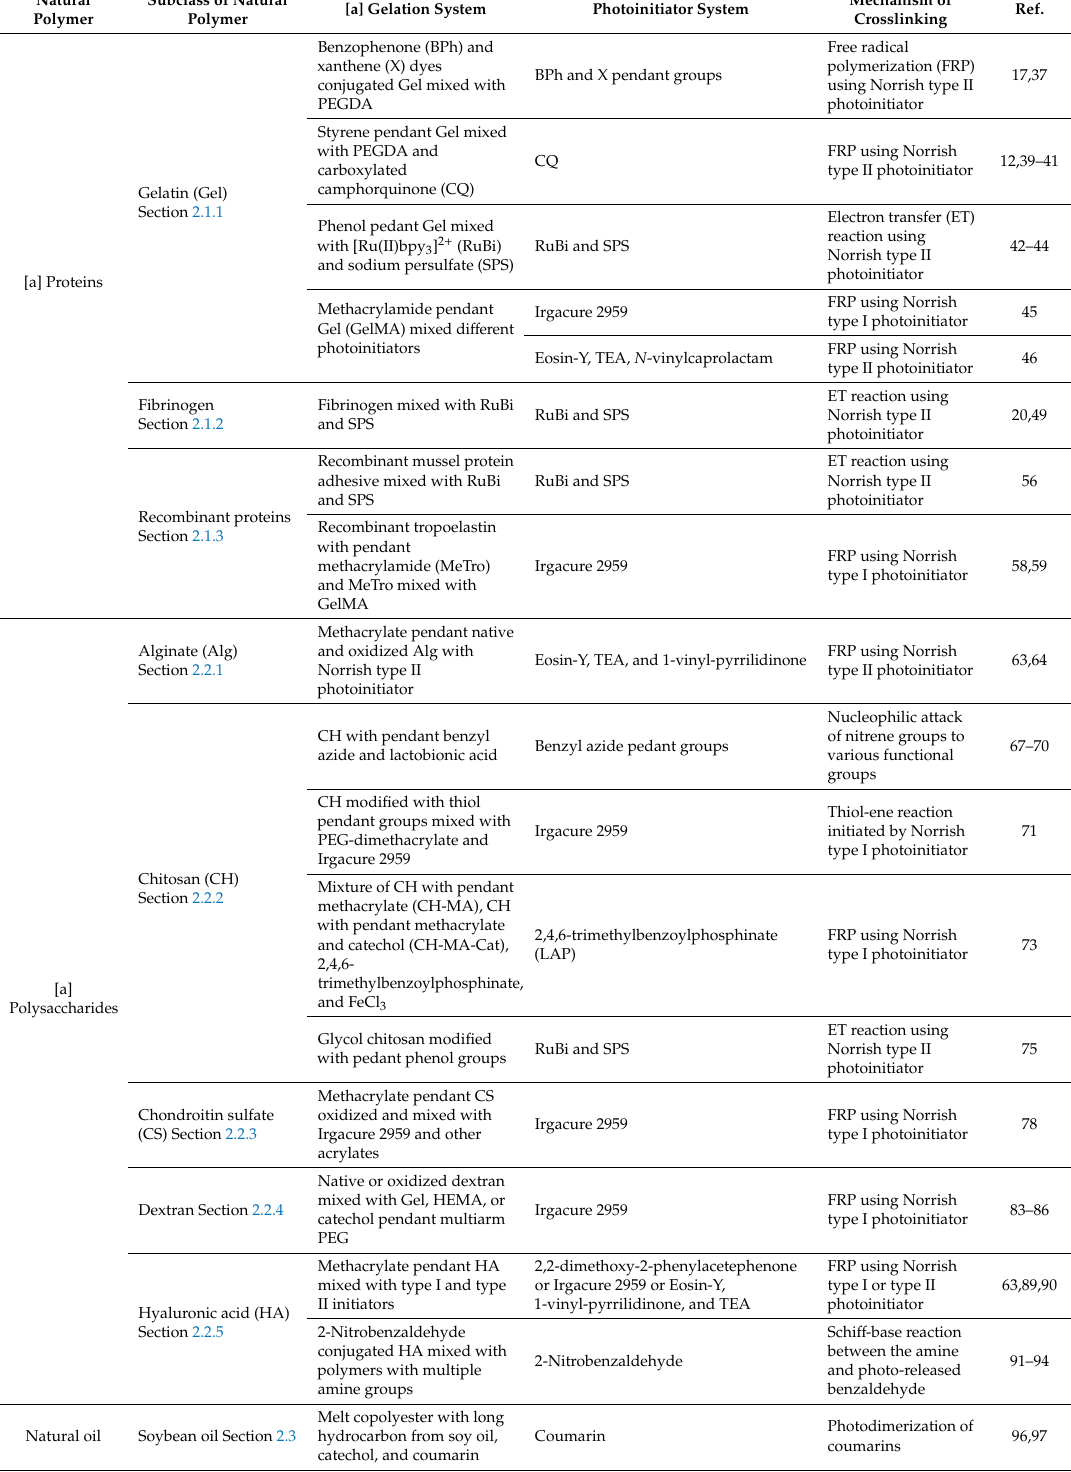
Table 1. Summary of the photoreactive tissue adhesives derived from natural polymers. Natural